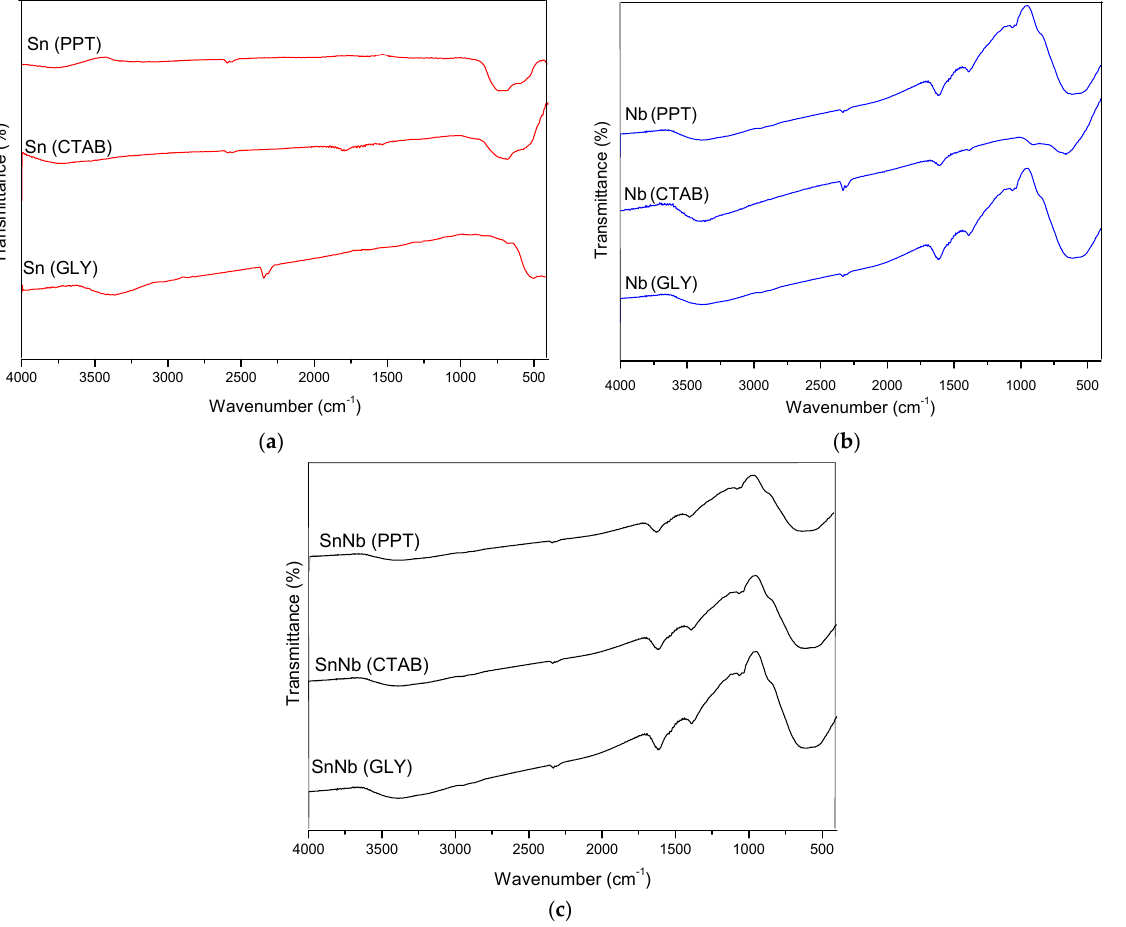
Figure 2. Infrared spectra of the catalysts: ( a ) Sn(PPT), Sn(CTAB) and Sn(GLY); ( b ) Nb(PPT), Nb(CTAB) and Nb(GLY); and ( c ) SnNb(PPT), SnNb(CTAB) and